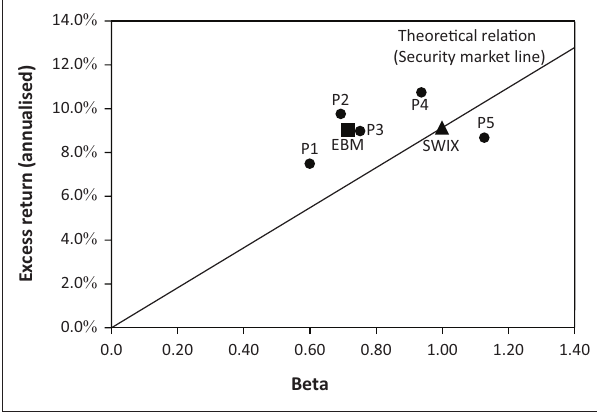
FIGURE 2: Beta sorted portfolios and the security market line.